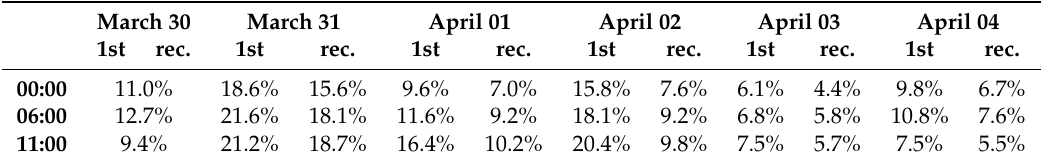
Figure 19. Evolution of the adaptive model of the photovoltaic plant over six days from 30 March to 4 April illustrated by comparing the most recent model to the first model as generated on 30 March. Table 8. Error values for Figure 19 all normalized to the largest value measured during those six days and calculated for the time interval from the forecast calculation until